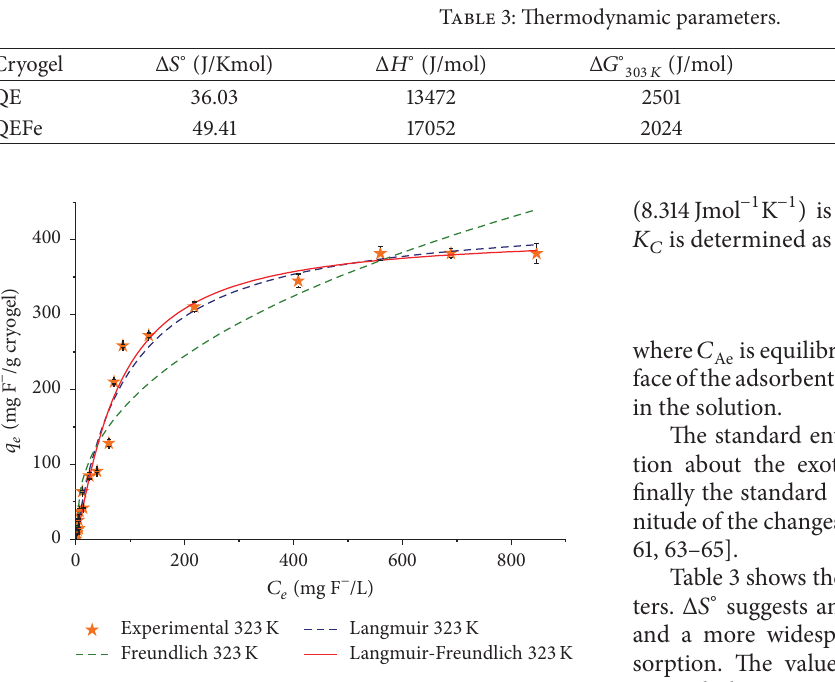
Figure 15: Sorption isotherms, cryogel QEFe fitted to Freundlich, Langmuir, and Langmuir-Freundlich models; 8mL, 24 hours of contact, 200 rpm, 0.002 g cryogel mass, pH 6, 𝑇 = 323 K, closed